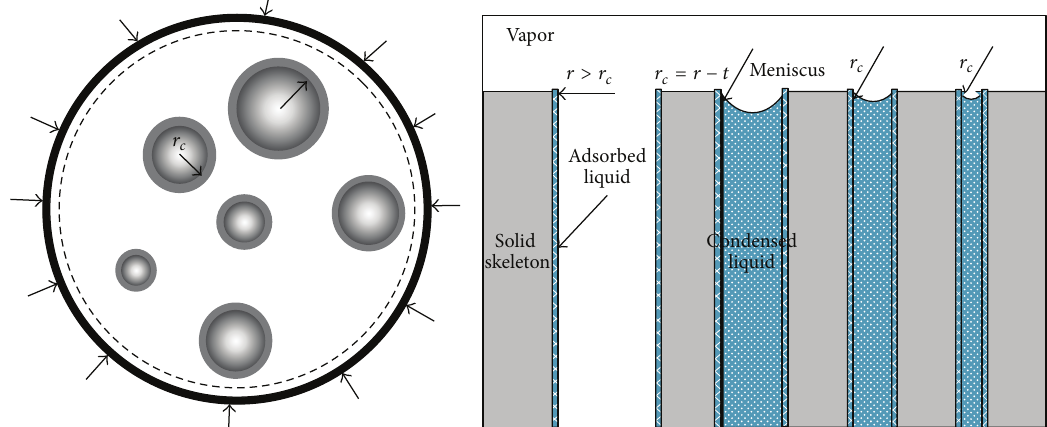
Figure 2: Schematic illustration of drying process with different pore sizes, the formation of meniscus and generation of capillary pressure.